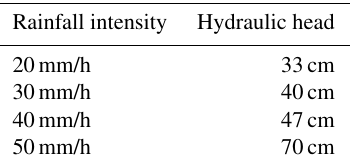
Table 1. Relation between rainfall intensity and hydraulic head ap- plied to sewer pipes (National Disaster Management Institute of Ko- rea, 2014).